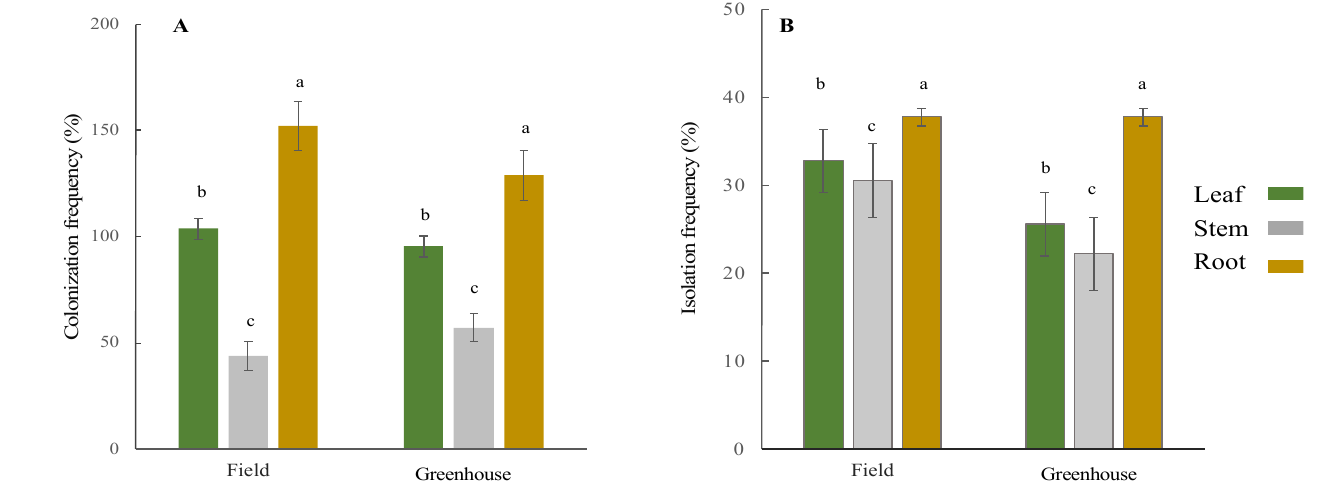
Figure 1. Colonization frequency ( A ) and isolation frequency ( B ) of endophytic fungi common to leaf, stem, and root tissues of hairy vetch ( Vicia villosa ) from two different growing conditions (field and greenhouse). The error bar indicates the standard error (SE) of the mean. Bars with different letters (a, b, c) indicate that the mean values are significantly different at a significance level of p < 0.05. The diversity and species richness of the endophytic fungi ( α -diversity) concerning the tissue types and growing conditions were measured using the Shannon–Wiener di- versity index (H’) and Simpson dominance index. All indices were calculated with PAST (Version 4) [55]. A higher α -diversity index is defined as higher species diversity and